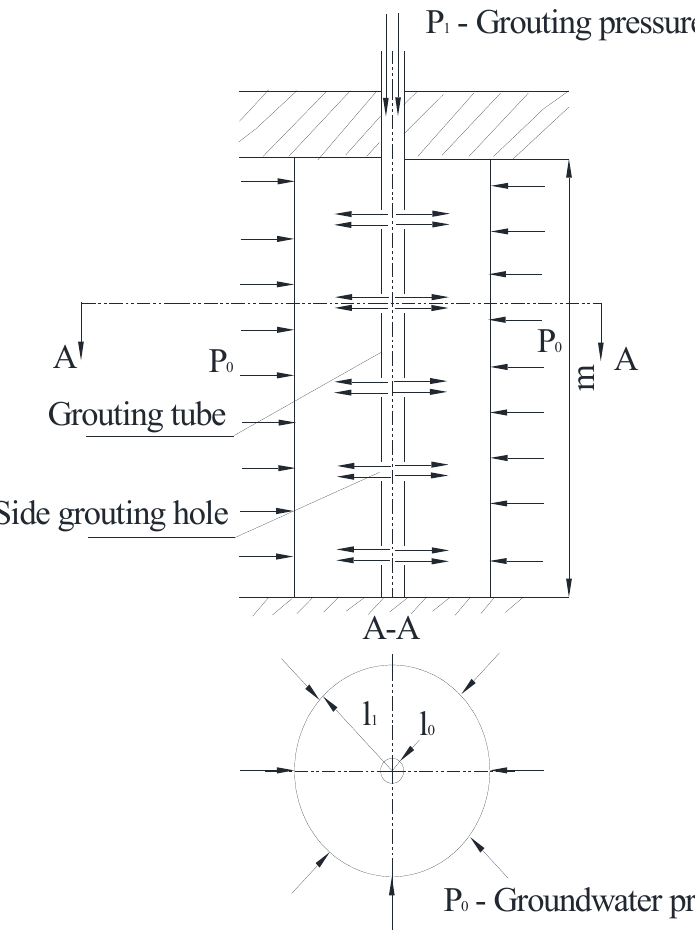
Figure 2. Column spreading model of a Newtonian fluid with time ‐ dependent behavior of viscosity.